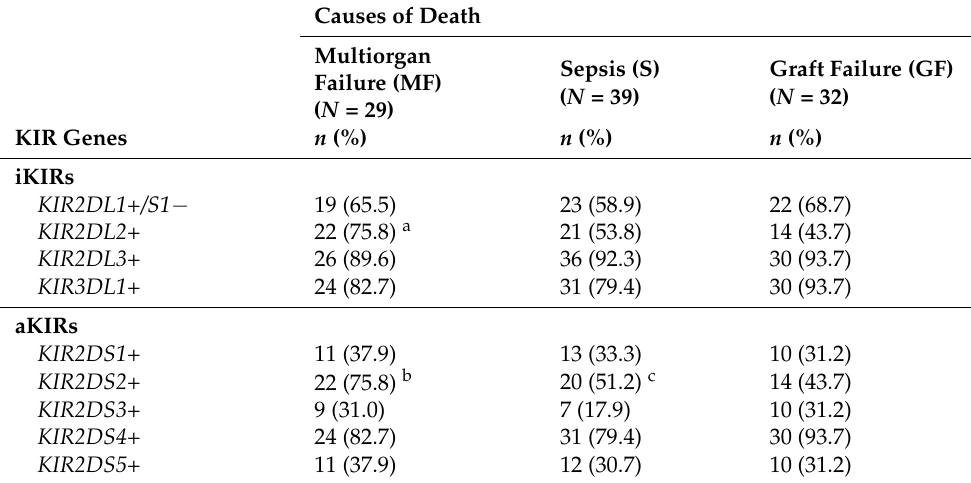
Table 2. Frequency of KIR genes in AC patients with different causes of